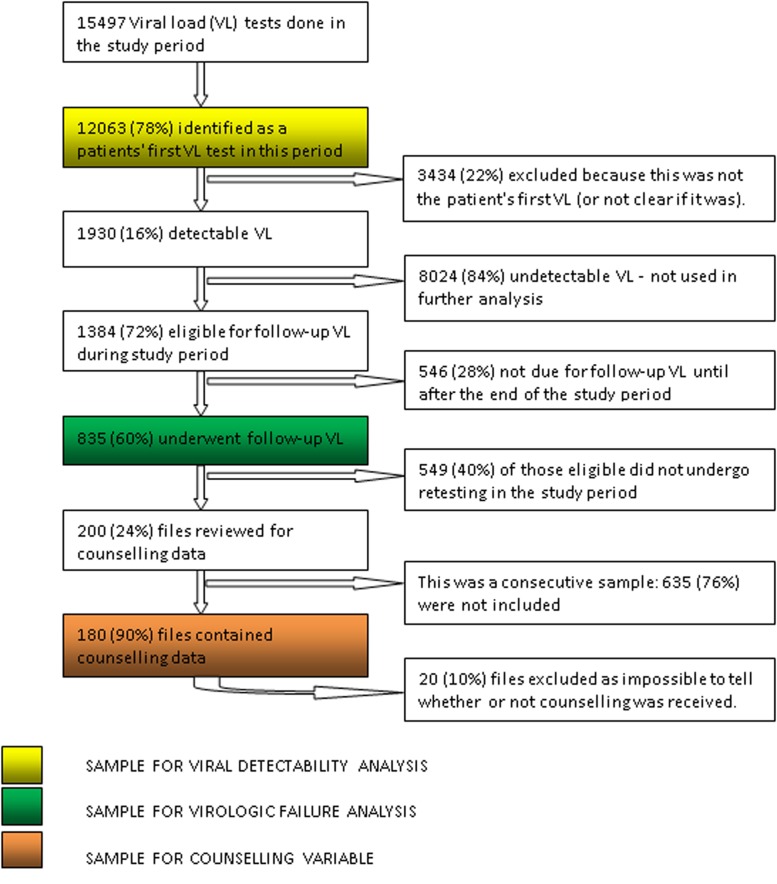
Numbers and proportions of viral load tests included and excluded at each stage of the analysis of predictors of virological outcomes, Swaziland, 2012–2013.